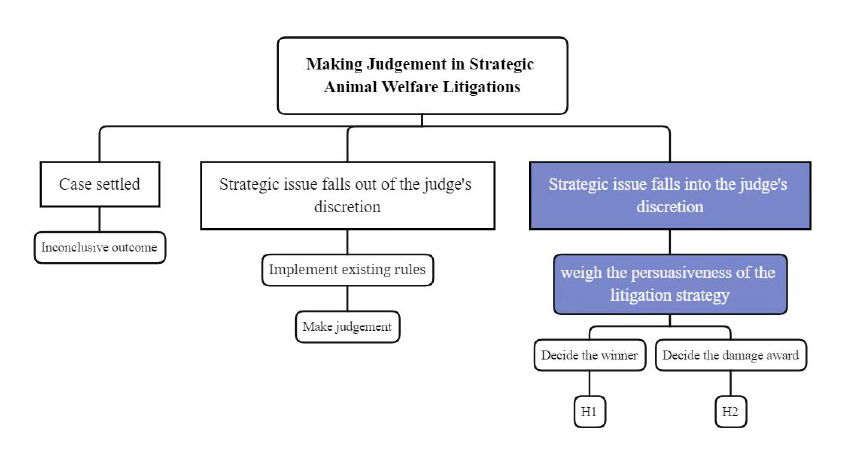
Figure 1. The ways judges react to litigation